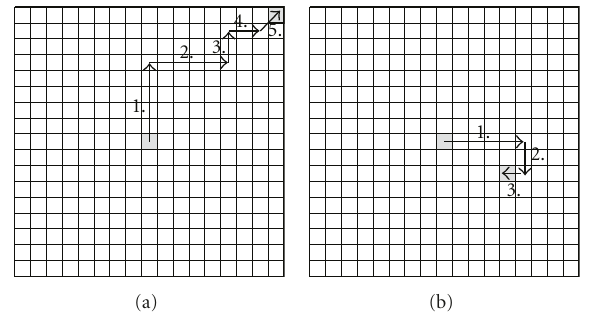
Figure 3: (a) Cell neighborhood connections. Example of (b) [8,8] shift, (c) [4, − 2]